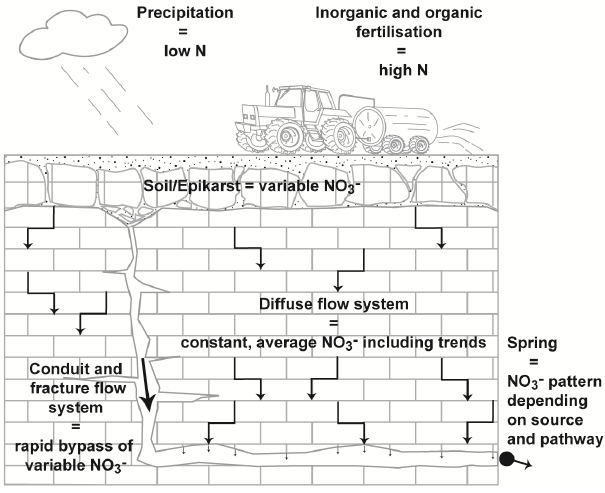
Figure 4. Conceptual model of nitrate response in karst systems.